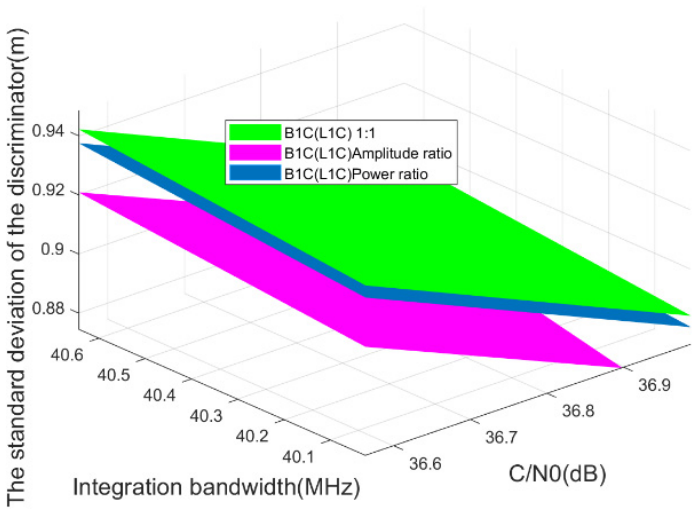
Figure 6. The DLL standard deviation.